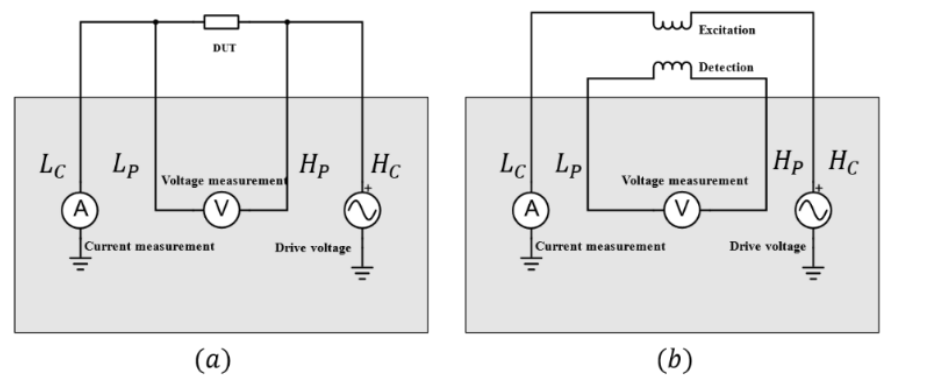
Figure 11. Frequency responses of eddy current probes.